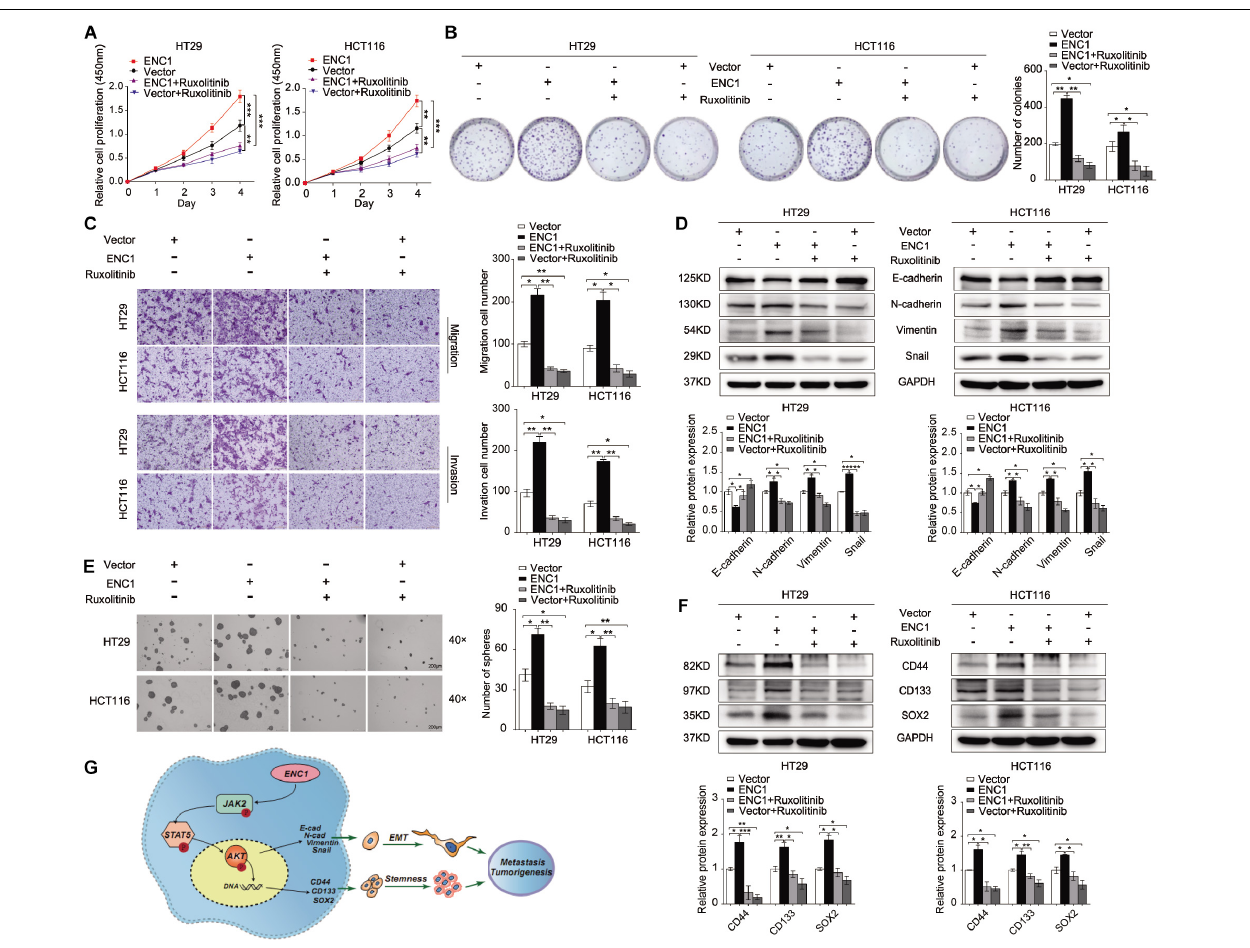
FIGURE 6 | ENC1 accelerates cell proliferation, migration, invasion, EMT, and stemness through activating JAK2/STAT5/AKT signaling in CRC. Cell proliferation was assessed by CCK8 assay (A) and colony formation assay (B) in ENC1-overexpression CRC cells treated with ruxolitinib. (C) Effects of ruxolitinib treatment on ENC1-overexpressed HT29/HCT116 cell motility and invasiveness capability were detected by Transwell assay. (D) Western blotting showed the protein changes of EMT markers between ENC1-overexpressed cells with and without ruxolitinib treatment. (E) Effect of ruxolitinib in tumor spheres caused by ENC1 overexpression in contrast with no treatment. (F) The expression of stemness markers (CD44, CD133, SOX2) were detected by Western blotting in ENC1-overexpressed CRC cells treated with ruxolitinib. (G) Schematic diagram of ENC1 promotes CRC tumorigenesis and metastasis via the JAK2/STAT5/AKT axis mediated EMT and stemness. Results are presented as the mean ± SD of three independent experiments. * P < 0.05, ** P < 0.01, and *** P <